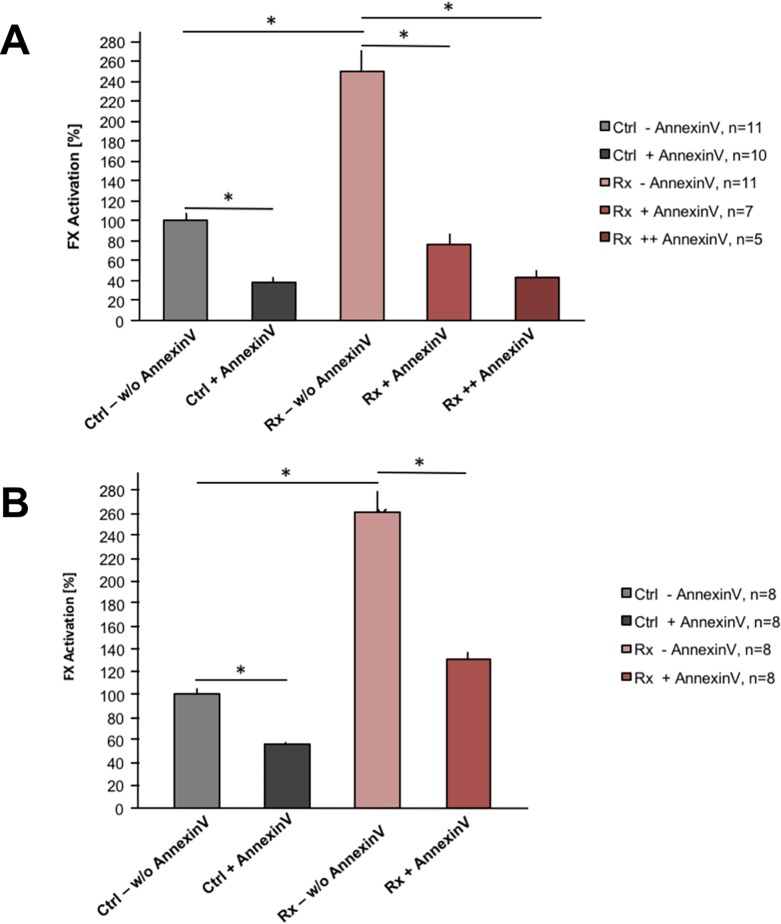
Factor X activation assay in the presence of human endothelial cells or human sarcoma cells with the variables of preceding irradiation and Annexin V incubation.(A) Human endothelial cells (HUVEC) were tested without (grey columns) versus with (red columns) previous irradiation (4 Gy) in a validated FX activation assay as described in the Methods section with identical amounts of tTF-NGR and all other test components present. Tests with 5 (+) or 10 (++) μg/105 cells of recombinant human Annexin V versus without (w/o) previous incubation of the cells with Annexin V (binding and masking PS) were compared. Results with cells without previous irradiation and without Annexin V incubation (Ctrl, control; w/o, without Annexin V) were given as 100%. Results with cells after irradiation (Rx, 4 Gy) are represented by the red columns (light red, without and dark red, with previous incubation with Annexin V). Results of 3 different experiments with numbers of assays given as n are shown with mean values and standard error (SE) bars. Asterisks represent comparisons with two-tailed p values <0.0001. (B) Human sarcoma cells (HT1080) were tested in the FX activation assay as described for (A). Results of 2 different experiments with numbers of assays given as n are shown with mean values and standard error (SE) bars. Asterisks represent comparisons with two-tailed p values <0.0001.